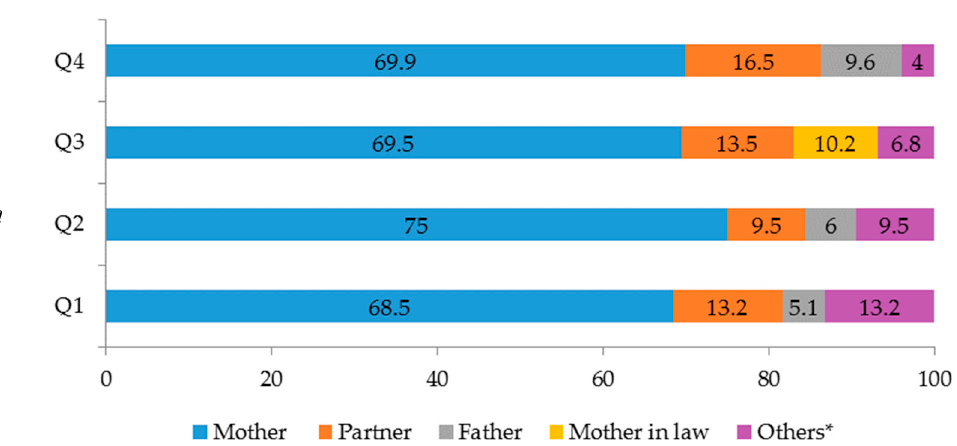
Figure 1. Members identified as the primary support during pregnancy, according to each quartile.